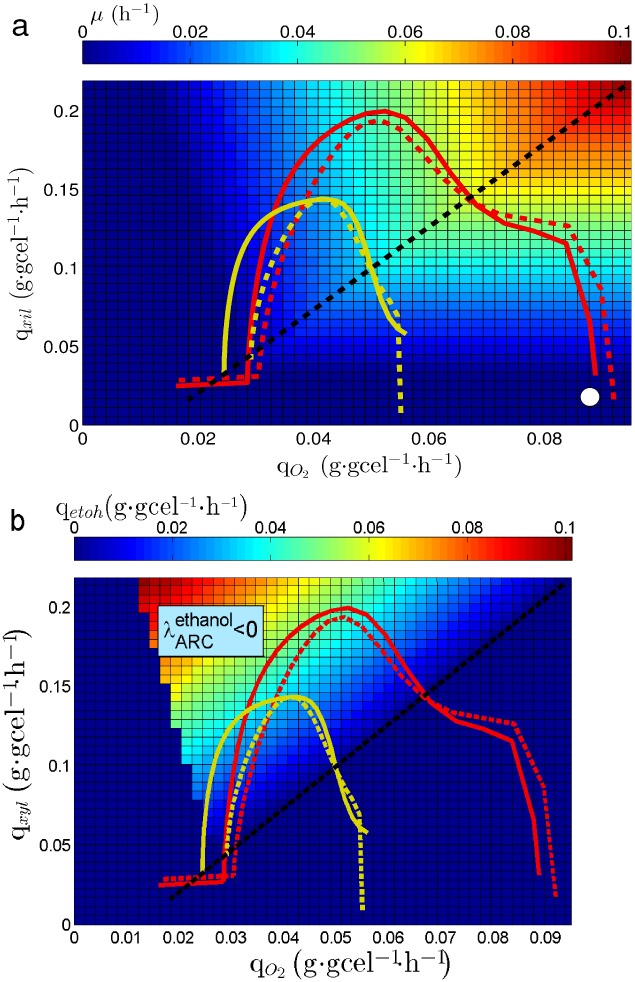
Culture trajectories on the PhPP.Solid yellow line: trayectory at kLa = 15 h−1 with no inhibition. Dashed yellow line: trayectory at kLa = 15 h−1 with inhibition. Solid red line: trayectory at kLa = 25 h−1 with no inhibition. Dashed red line: trayectory at kLa = 25 h−1 with inhibition. Dashed black line: line of optimality for biomass yield. (a): Colored contours for μ. (b): Colored contours for qetoh. White circle indicates the start of trajectories.